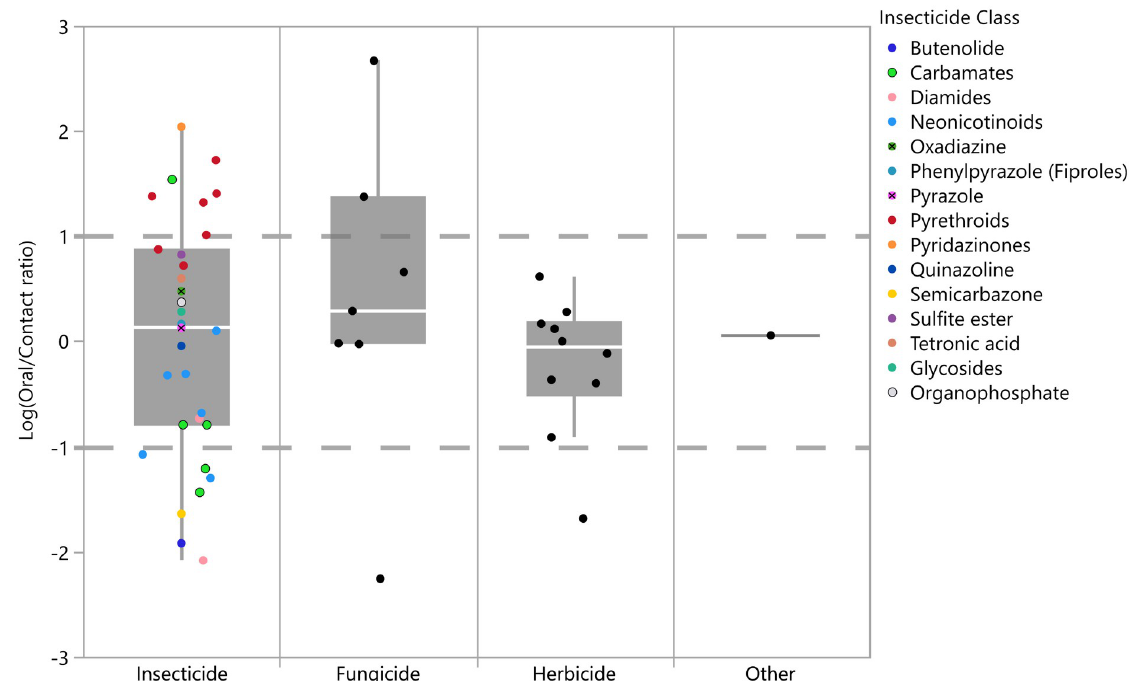
Fig 3. Ratios of adult honey bee ( Apis mellifera ) acute oral and contact LD 50 value across pesticide classes. Presented data are log 10 (ratio of oral LD 50 to contact LD 50 ). Dashed lines represent ten-fold deviations from a 1:1